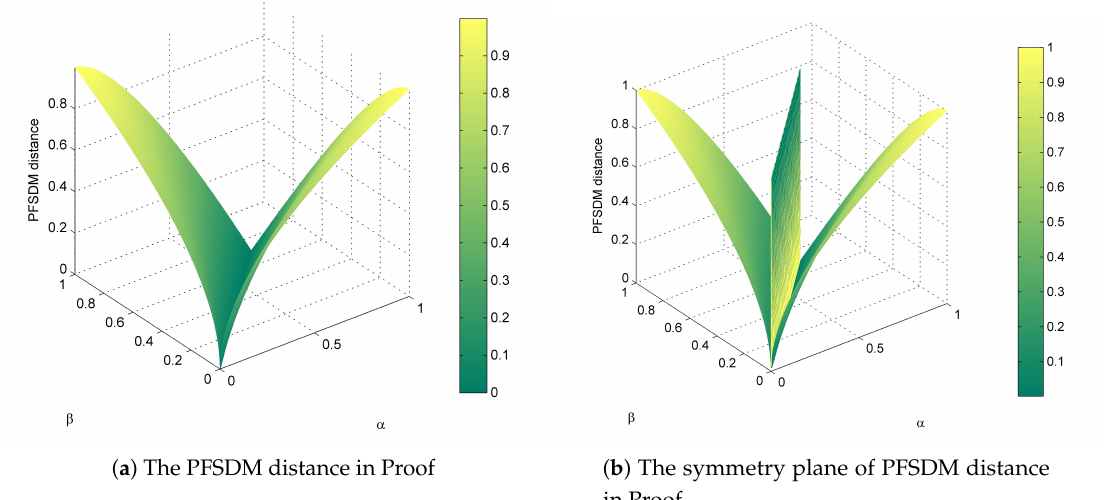
( b ) The symmetry plane of PFSDM distance in Proof Figure 1. The results in the proof.